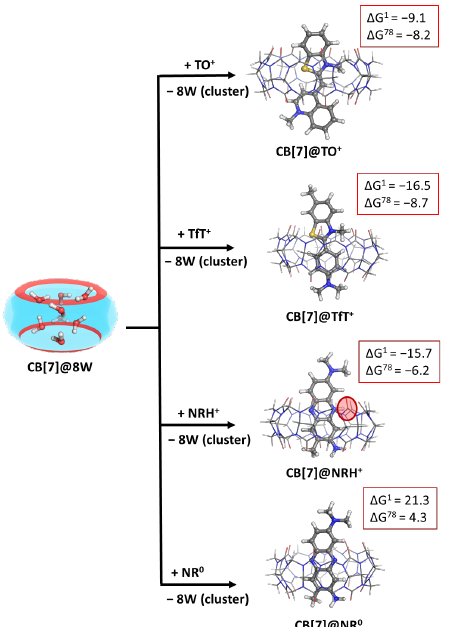
Figure 3. M062X/6 − 31G(d,p) optimized structures of the CB[7]@dye complexes in the gas phase and the corresponding ∆G ε values in kcal mol −1 for their formation in the gas phase ( ε = 1), and water ( ε = 78) at the M062X/6 −3 1+G(d,p)//M062X /6 −3 1G(d,p) level of theory. The results are obtained by considering the cucurbituril with high-energy water molecules (denoted as CB[7]@8W) as an initial structure. The coming dye molecule/ion fully substitutes the water cluster from the host cavity.